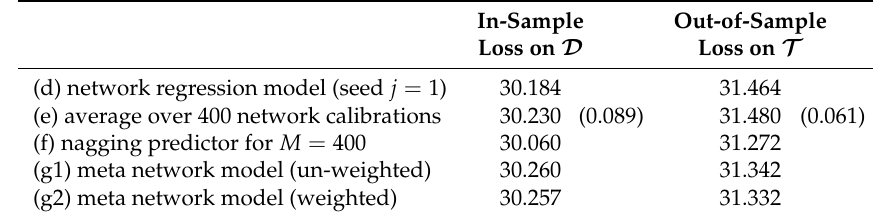
Figure 8. Gradient descent fitting of meta model: (lhs) unweighted square loss function, (rhs) weighted square loss function. Table 3. (d)–(f) Network regression models from Table 2 compared to meta models (g1)–(g2); losses are in 10 − 2